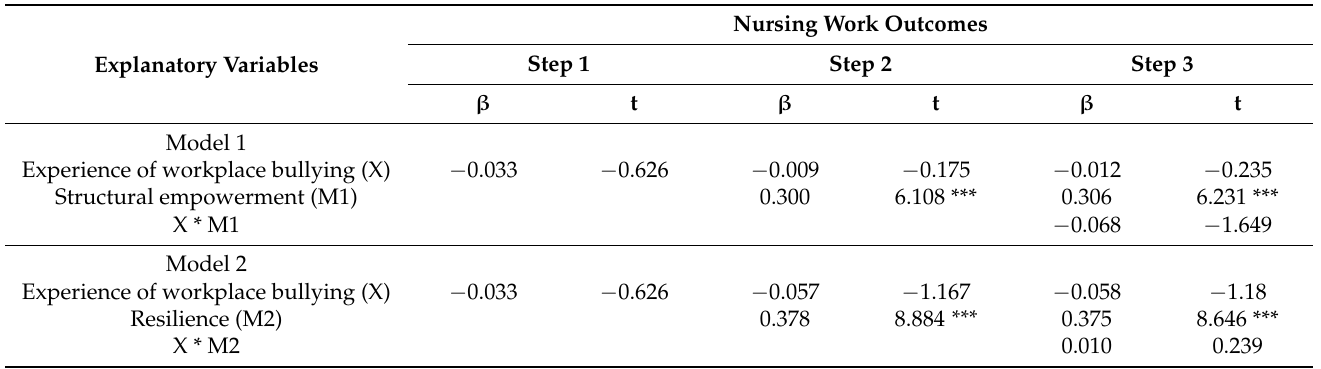
Table 3. Associations between the experience of workplace bullying (X), structural empowerment (M1)/resilience (M2), and nursing work outcomes (Y).